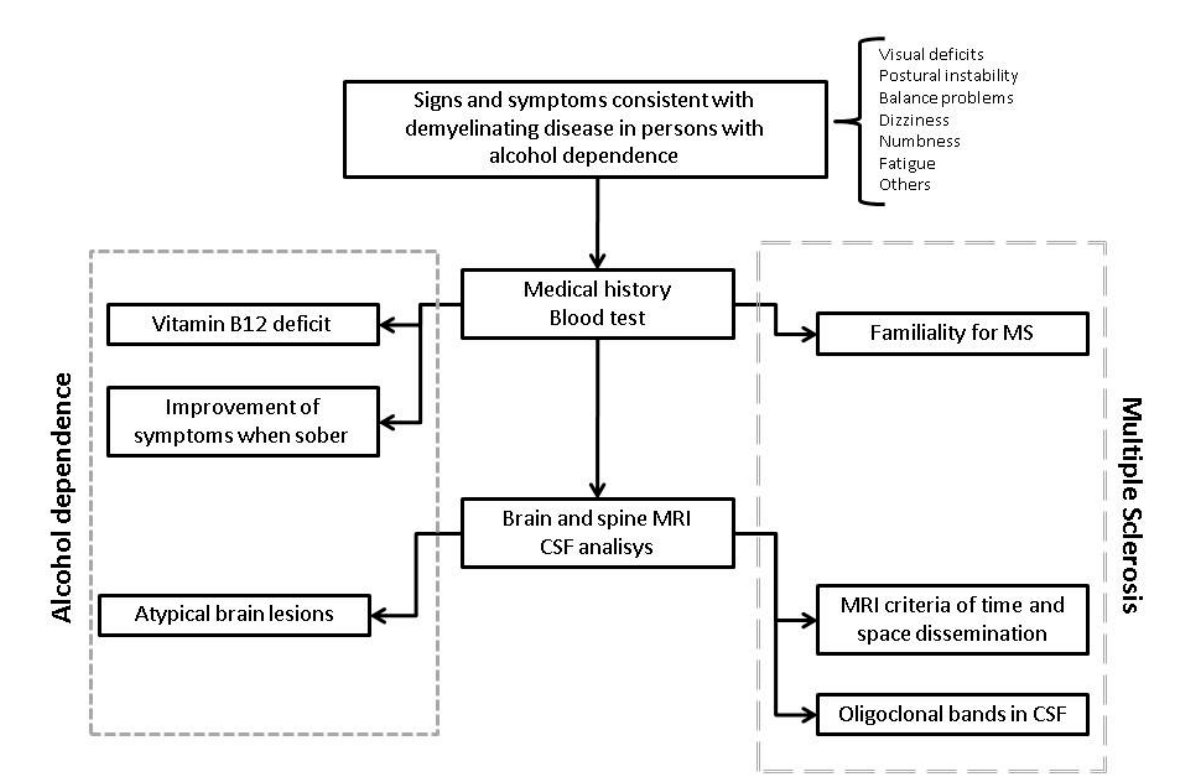
Figure 3. Alcohol-related neurological condition or multiple sclerosis? The figure shows (in an oversimplified manner) our reasoning when handling this case. The flowchart has been enriched with general data (e.g., familiarity, cerebrospinal fluid analysis) that may be useful in similar cases. The left side of the figure summarizes the aspects that may suggest a diagnosis of neurological condition secondary to alcohol dependence. The right side shows the aspects soliciting a diagnosis of multiple sclerosis. CSF: cerebrospinal fluid.